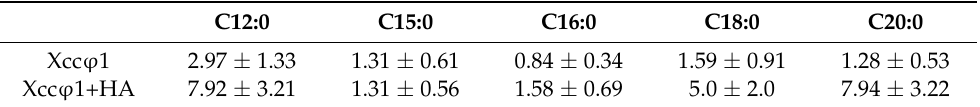
Table 1. The values (C syn ) are the result of the mathematical analysis used to obtain the combination of acids, phage, and HA showing the best synergistic effect.